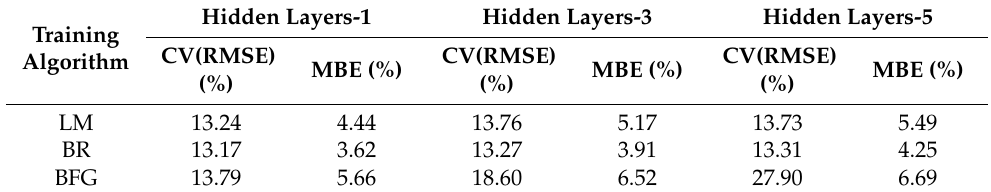
Figure 5. Prediction results of PM 2.5 concentration. ( a ) LM-Hidden layer-1; ( b ) LM-Hidden layer-3; Table 4. CV(RMSE) and MBE of PM 2.5 concentration prediction result. ( c ) LM-Hidden layer-5; ( d ) BR-Hidden layer-1; ( e ) BR-Hidden layer-3; ( f ) BR-Hidden layer-5; ( g ) BFG-Hidden layer-1; ( h ) BFG-Hidden layer-3; ( i ) BFG-Hidden layer-5.